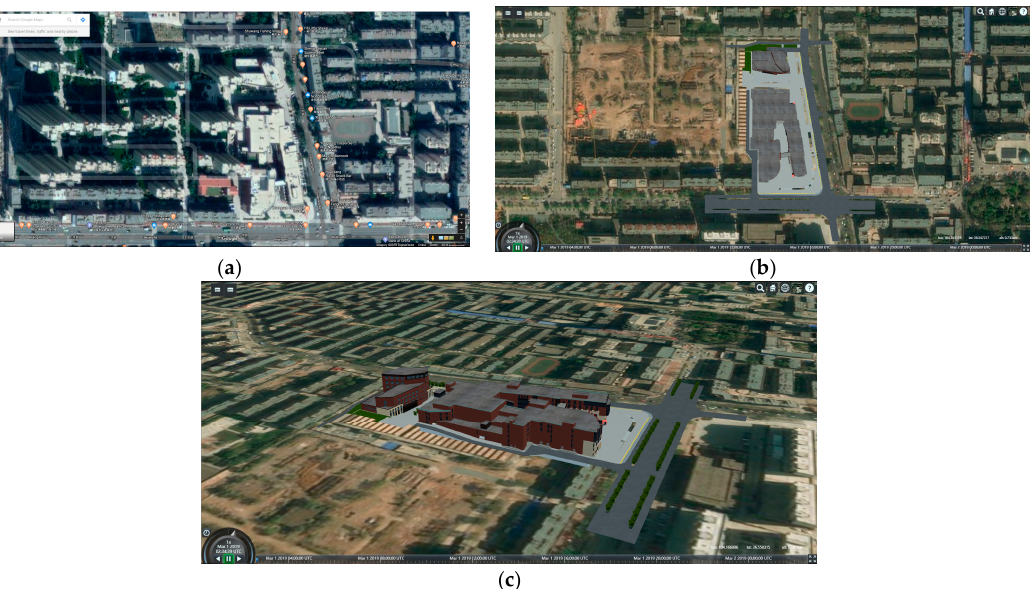
(Baiyu City Commercial Street), as shown in Figure 13.